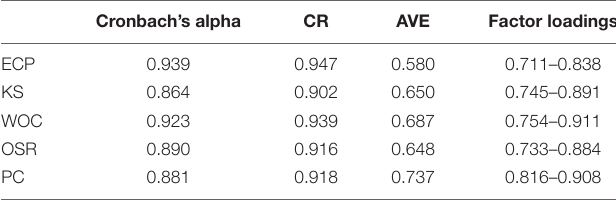
TABLE 2 | Reliability and validity.